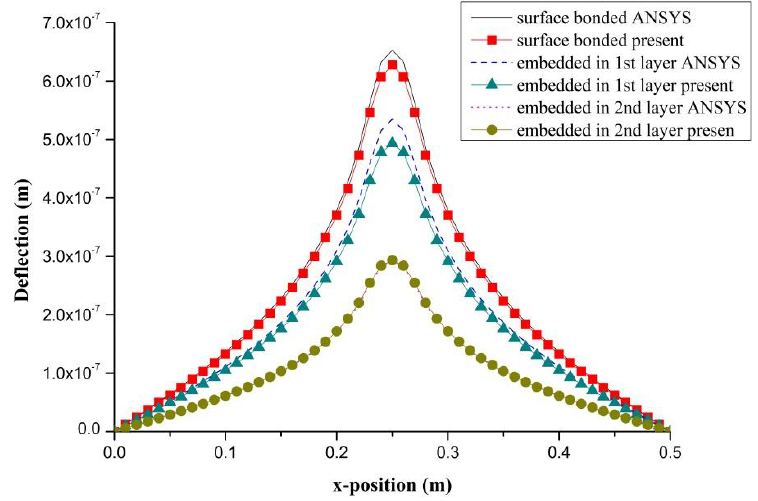
Figure 13. Deflection along the horizontal line ( y = 0.25 m) of the composite laminate plate induced by a PZT actuator embedded in different depths.